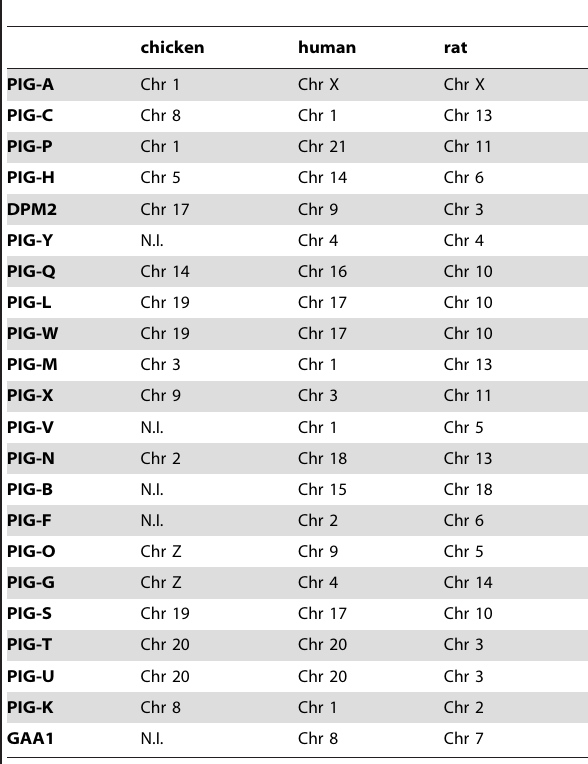
Table 1. Chromosome location of GPI anchor synthesis